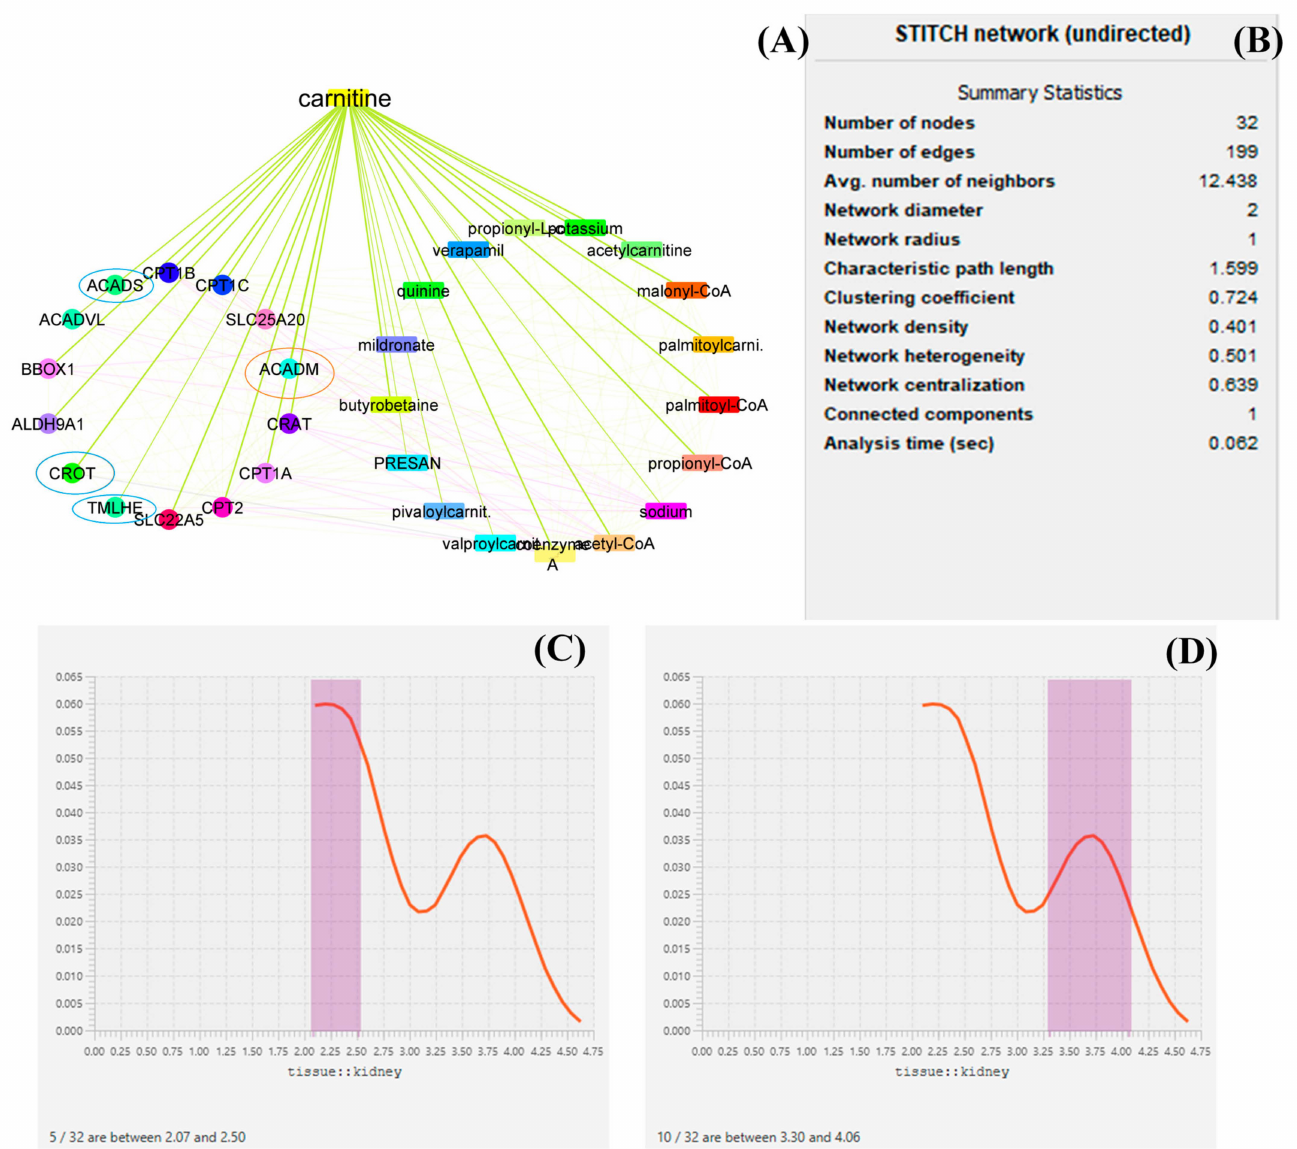
Figure 2. Network biology and pharmacology of LC based on datamining sources. the study revealed the biomolecular role of LC based on its network as well as gene pathology. in this diagrammatic representation, ( A ) represents the biological networks and their interaction with the genes involved in LC biosynthesis, function, the provision of energy, and biodegradation. ( B ) represents the statistical summary of CPI network, this network possesses 32 nodes with 199 interacted edges. ( C , D ) represent a histogram of the most prominent genes and their roles in maintaining kidney function. In ( A ), the red circle represents histogram ( D ) and the blue circle represents histogram ( C ). The genes under the circle are characterized as the most prominent genes involved in